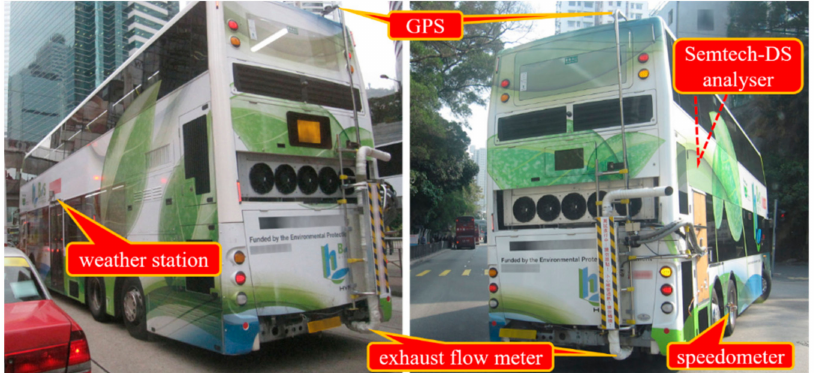
Figure 1. Euro VI diesel-hybrid bus during trials in the streets of Hong Kong. GPS: global positioning system; Semtech-DS analyser (Sensors, Inc., Saline, MI,